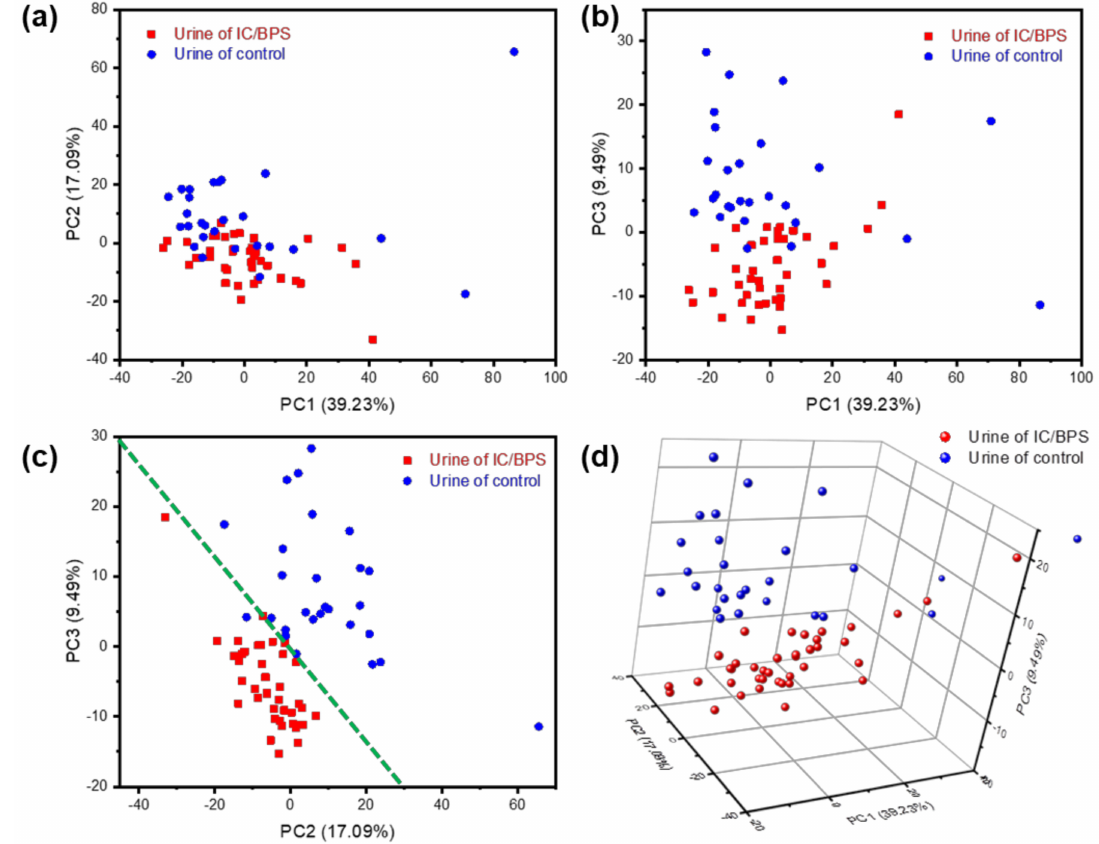
Figure 5. Principal component analysis results for urine of IC/BPS and control sample: ( a ) PC1 (39.23%) vs. PC2 (17.09%); ( b ) PC1 vs. PC3 (9.49%); ( c ) PC2 vs. PC3; ( d ) 3D plot of PC1, PC2, and